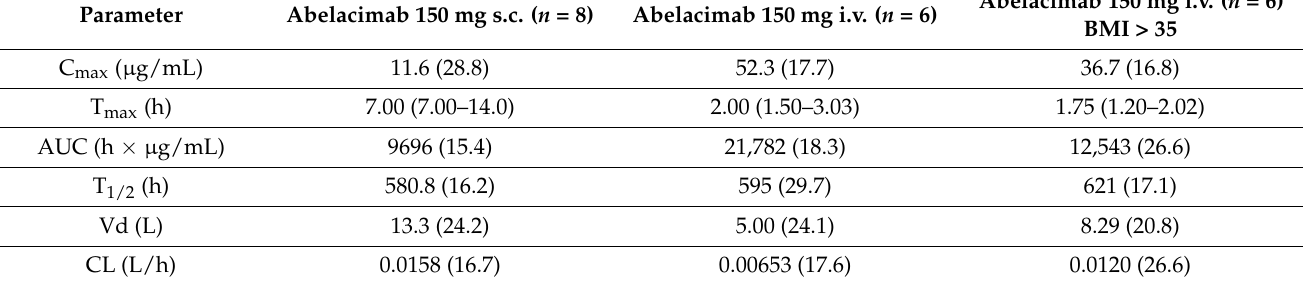
Table 3. Plasma pharmacokinetic parameters of abelacimab. Geometric Mean (Geometric